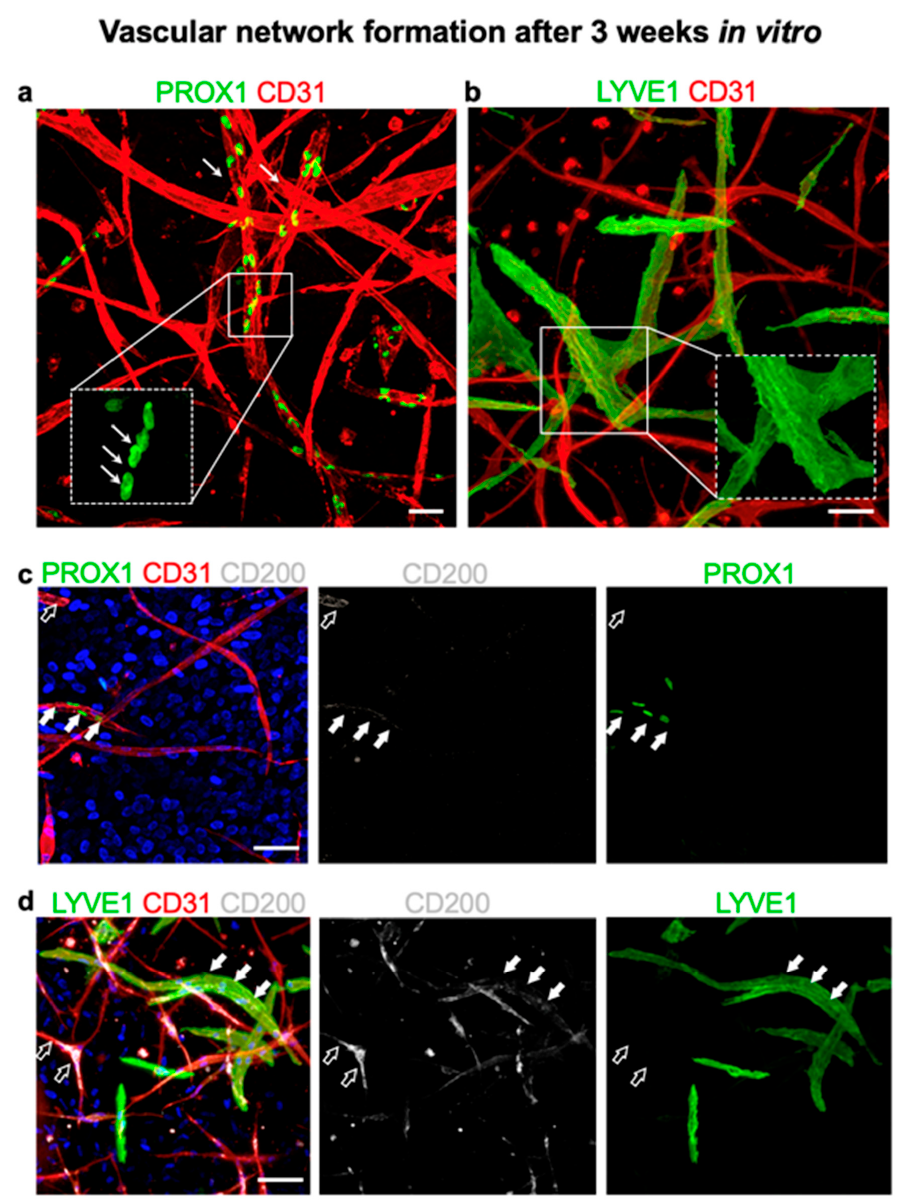
Figure 6. Expression of CD200 on in vitro cultured blood and lymphatic capillaries in 3D collagen. ( a ) Collagen type I-based hydrogel, and stained for endothelial-specific marker CD31 (red) and lymphatic lineage marker PROX1 (green) ( n = 5). Whereas double-positive CD31 + PROX1 + capillaries represent lymphatics, single positive CD31 + PROX1 − demonstrate blood capillaries. The lower inset shows a higher magnification of the single nuclear PROX1 staining in lymphatic capillaries (arrows). ( b ) The merged confocal immunofluorescence showing CD31 + blood capillaries (red) and lymphatic capillaries positive for CD31 + (red) and LYVE1 (green), which is a lymphatic-specific marker. Insets show a magnification of single-stained LYVE1 lymphatic capillaries. ( c ) Triple stained image of human capillary network co-stained for PROX1 + (green) CD200 + (white) CD31 + (red). Accordingly, PROX1 + CD200 + CD31 + .triple positive capillaries represent lymphatics expressing CD200 marker (filled arrows), whereas double-positive PROX1 − CD200 + CD31 + staining demonstrates blood capillaries positive for CD200 (empty arrows). ( d ) Triple co-staining for LYVE1 + (green) CD200 + (white) CD31 + (red). Whereas the majority of lymphatic capillaries (CD31 + LYVE1 + ) were positive for CD200 (filled arrow), only a few blood capillaries (CD31 + LYVE1 − ) expressed CD200 (empty arrows). The results are representative from n = 3 biological samples of EC populations. Cell nuclei are stained with Hoechst (blue). Scale bars: ( a – d ): 50 µ